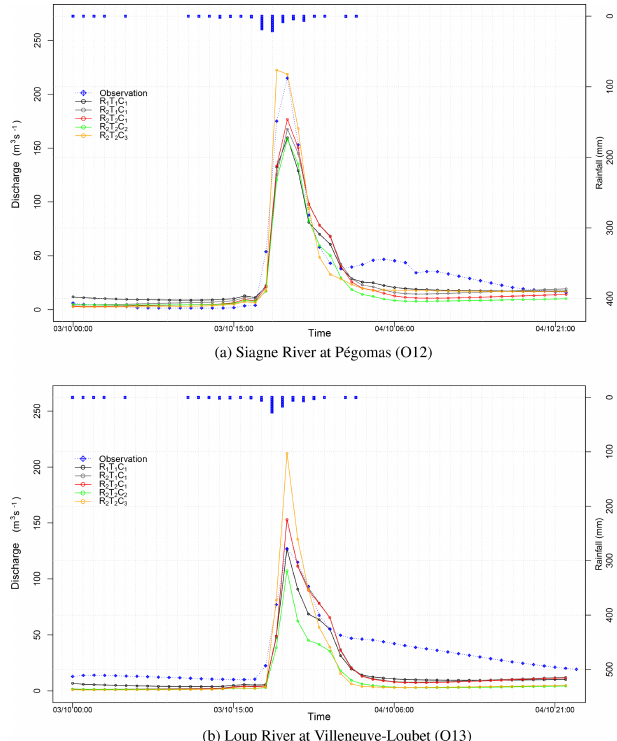
Figure 8. Discharge time series observed (blue curve) and simu- lated by ISBA-TOP in the five experiments R 1 T 1 C 1 –R 2 T 2 C 3 for 3 October 2015 for (a) the Siagne river at Pégomas and (b) the Loup river at Villeneuve-Loubet. The reverse histogram represents the hourly rainfall averaged over the